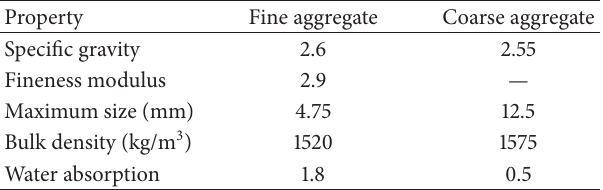
Table 1: Physical and mechanical properties of the aggregates.